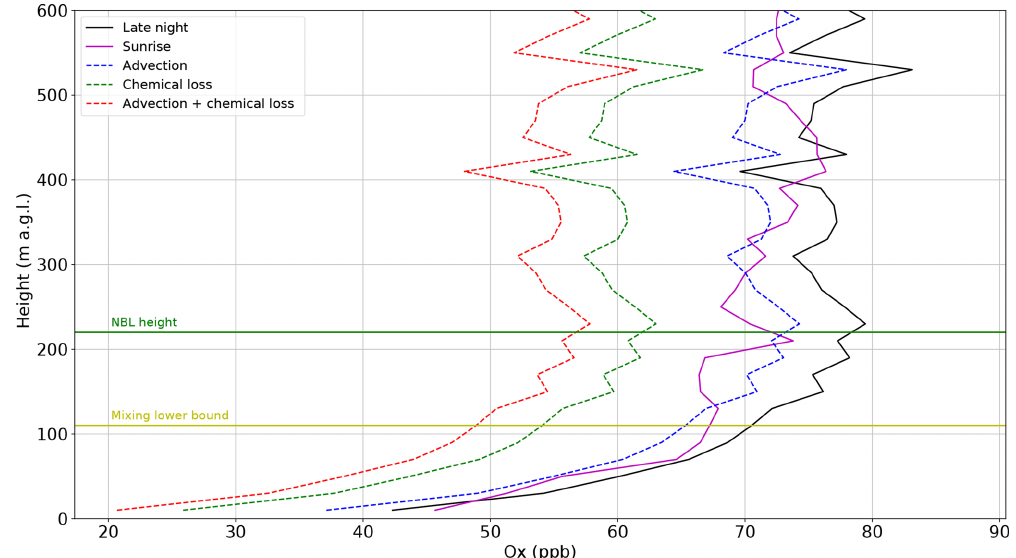
Figure 6. O x profiles from 4 June 2016 overnight analysis, NBL height (green line), and lower bound to vertical mixing gradient (yellow line). The solid lines are observations and the dashed lines are calculated based on expected changes due to horizontal advection (blue), chemical loss (green), and the sum of the two (red). Table 3. Results from the nocturnal scalar budget for all terms. Estimated error (see Sect. 3.2) in parenthesis. Flight date Storage Advection Chemical loss Vertical mixing Deposition Eddy diffusivity ppbh −